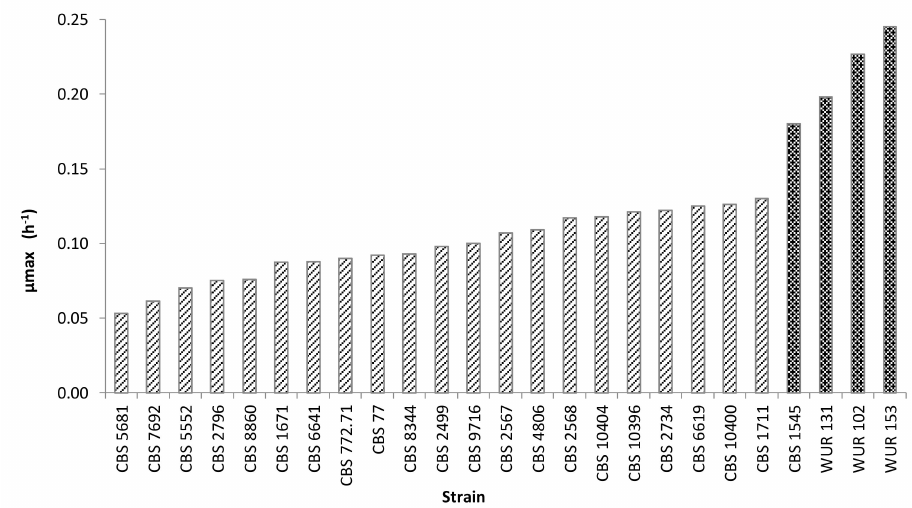
Figure 1. Growth rates of the strains employed in the screening (yellow CAJ, 25 ◦ C). Striped bars indicate non-conventional yeasts; dark bars, Saccharomyces